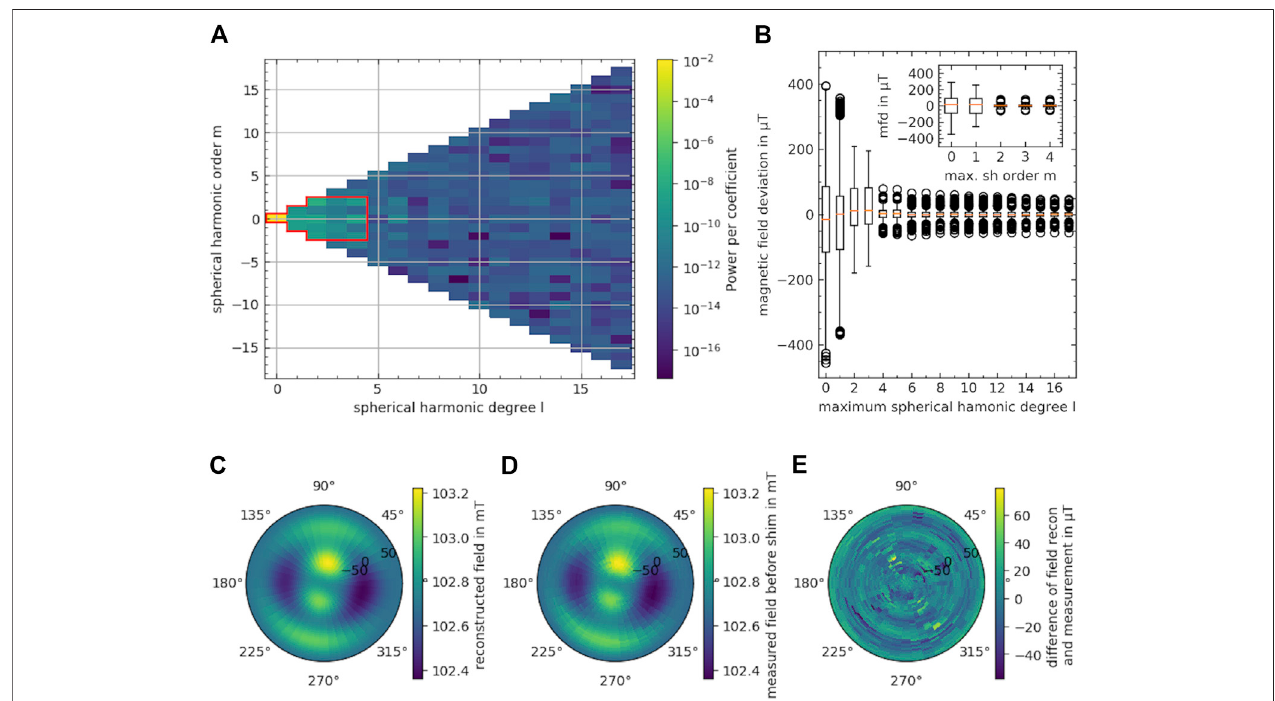
FIGURE 8 | Evaluation of the measured magnetic fi eld distribution on the 4 cm 3D sphere of the base magnet. (A) Power per spherical harmonic coef fi cient of the measurement. In red the truncated spherical harmonic coef fi cients are enclosed. (B) Boxplot of the point wise difference between the measured data and the reconstruction truncated at a maximum spherical harmonic degree. In the inset, the point wise difference for a maximum spherical harmonic order is displayed for the truncatedsphericalharmonicsatdegreefour.Theboxextendsfromthelowertotheupperquartile,theorangelinerepresentsthemedianandthewhiskersextend according to Tukey ’ s boxplot. Outliers are indicated as circles. (C) Reconstruction of the measured fi eld of the unshimmed desktop magnet with the truncated coef fi cients displayed in the red box in A. The fi eld is displayed in polar projection, with the center of the depiction being at the greatest x coordinate. (D) Measured fi eld without reconstruction. (E) Residuum of reconstruction and measurement.